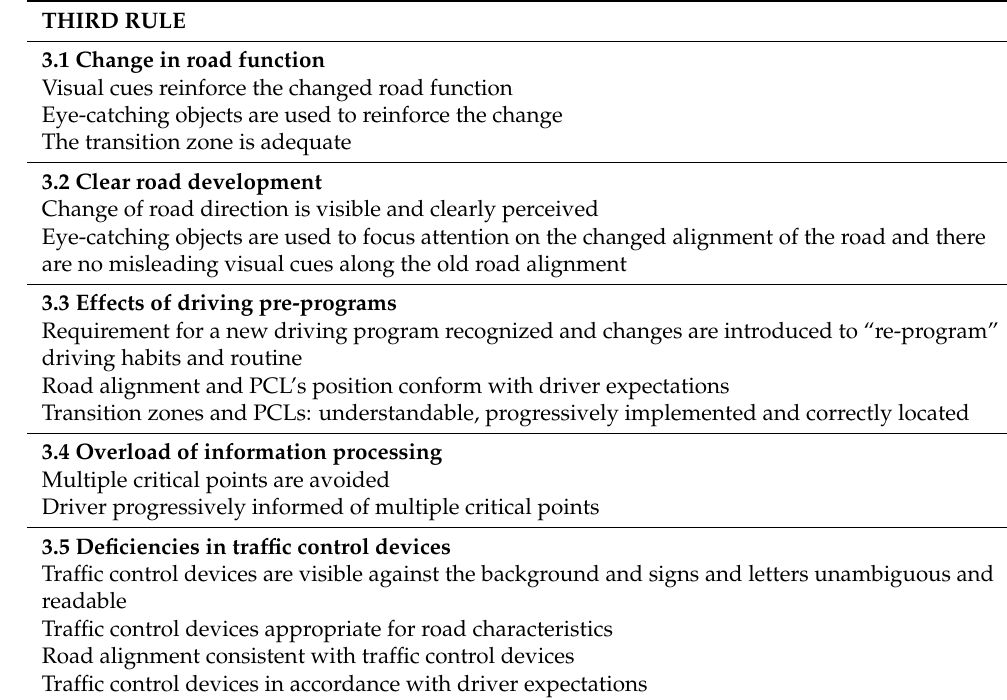
Table 3. Investigation topics and their related subsections for the Third rule of HF